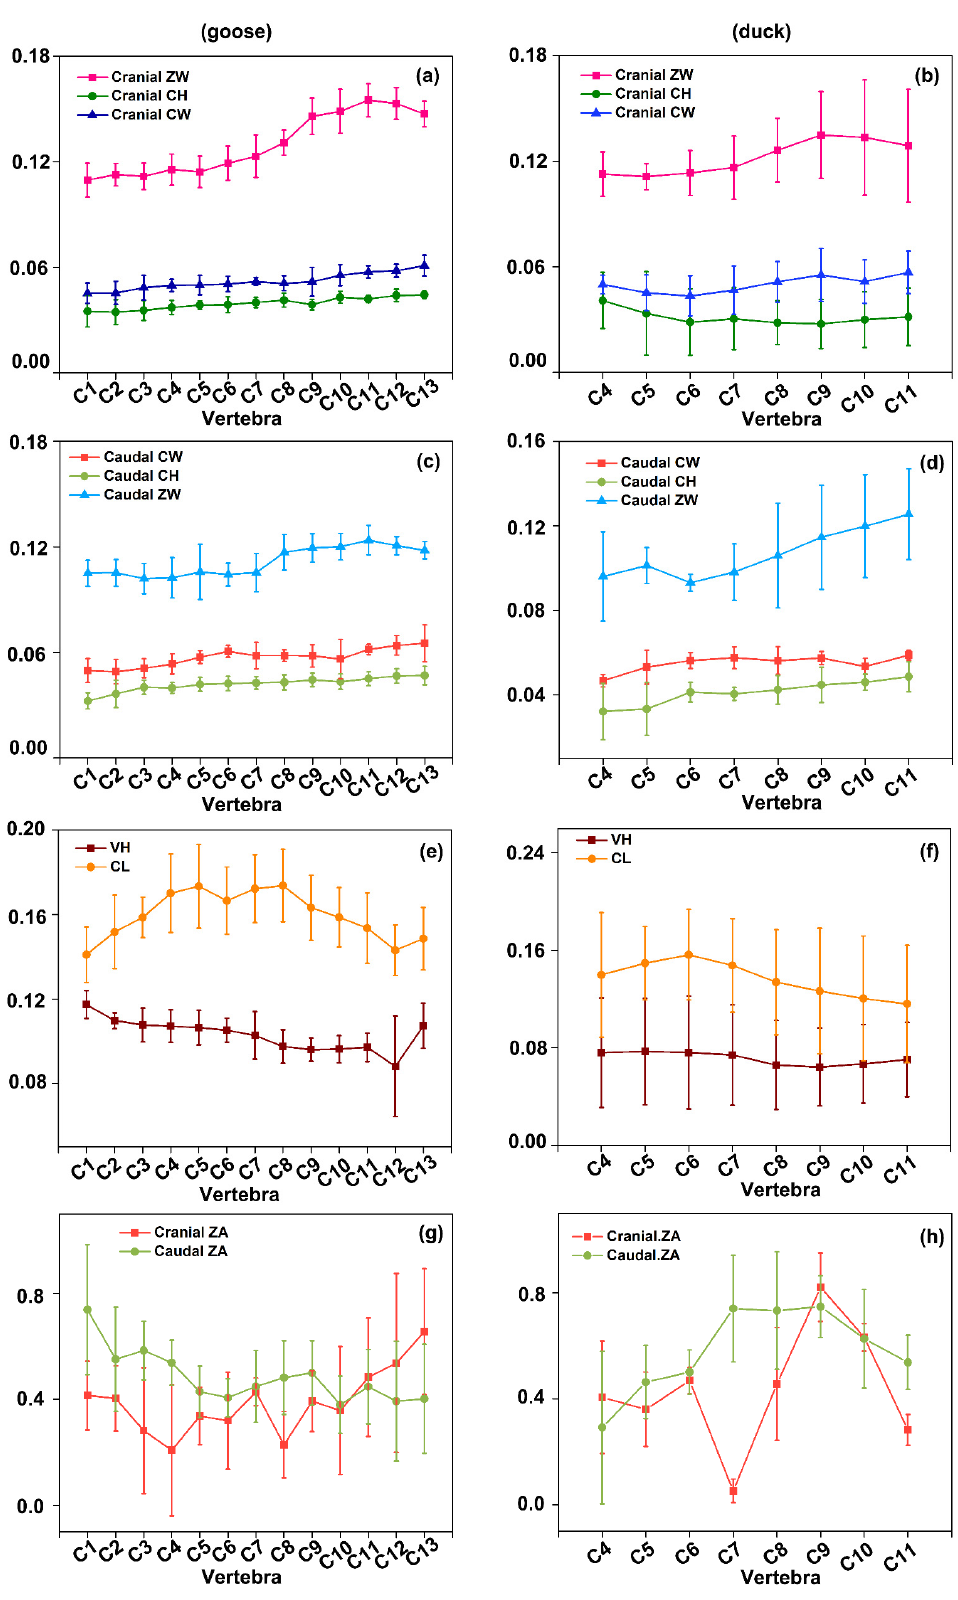
Figure 4. The linear and morphological angle measurements of goose and duck, Standardized processing of the original data, Mean and standard deviations are plotted. ( a , b ) ZW, CH, CW of Cranial of goose and duck. ( c , d ) ZW, CH, CW of Caudal of goose and duck. ( e , f ) VH and CL of goose and duck. ( g , h ) ZA of Cranial and Caudal of goose and duck.